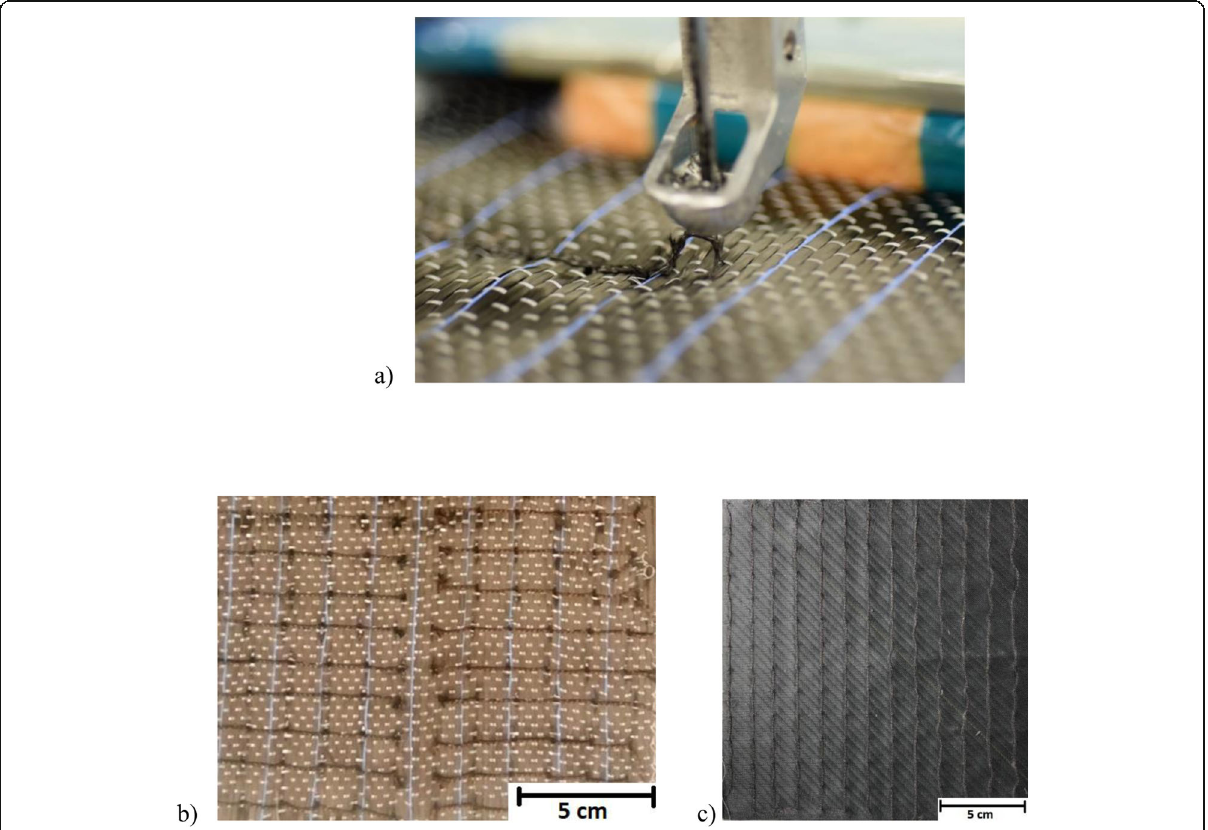
Fig. 4 a Close up of tufting needle showing braid being tufted into a unidirectional preform. b A tufted unidirectional carbon fibre preform with two sets of braids which contain different materials, c An infused and cured quasi-isotropic carbon fibre-epoxy (Prime 27) panel tufted with carbon-copper